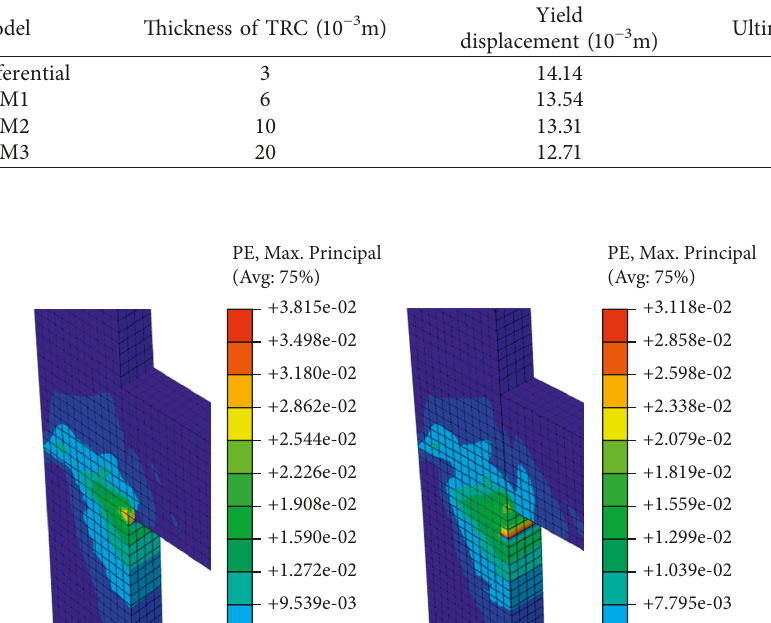
Table 17: Yield and ultimate displacement for ductility